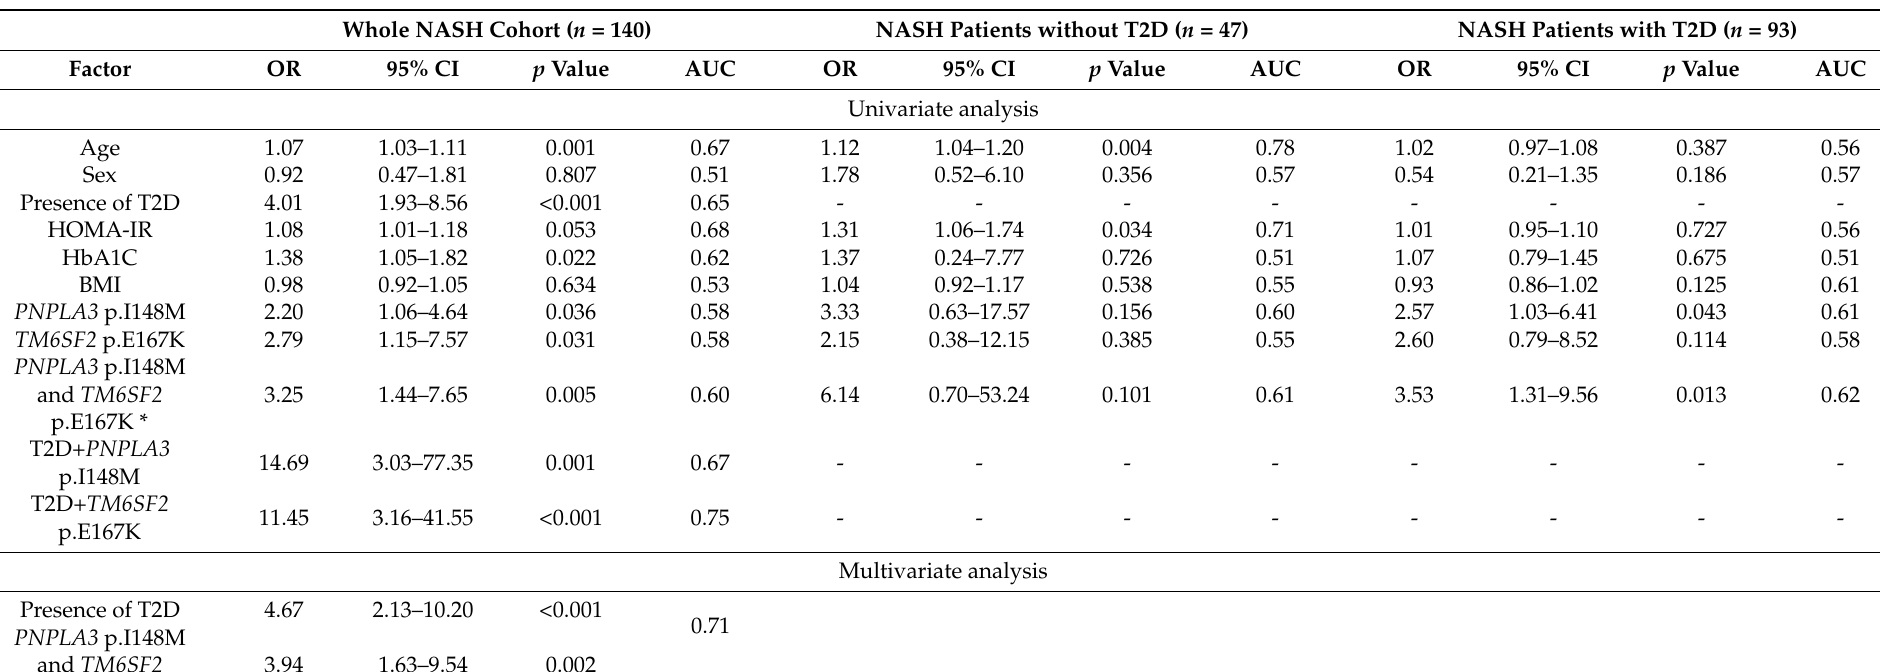
Table 4. Risk factors for developing advanced liver fibrosis in the entire NASH cohort and subdivided respect to T2D status. Whole NASH Cohort ( n = 140) NASH Patients without T2D ( n =